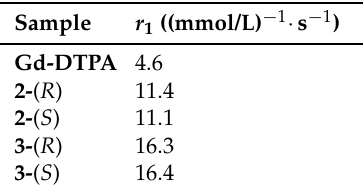
Table 1. Longitudinal relaxivities ( r 1 ) of Gd-DTPA, 2- ( R ), 2- ( S ), 3 -( R ) and 3 -( S ).